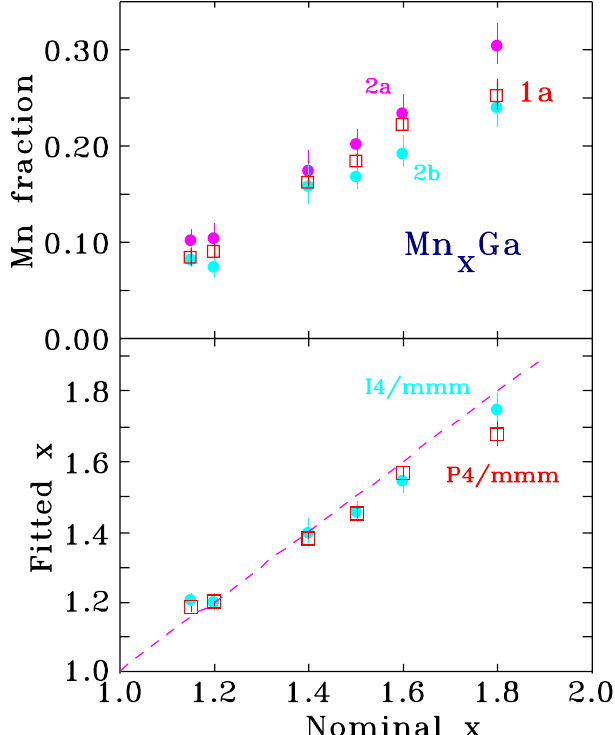
Figure 3. (top) Fitted Mn occupations of the 2 a and 2 b sites (assuming an I4/ mmm cell) compared with the Mn occupation of the 1 a site assuming the simpler P4/ mmm cell). (bottom) Stoichiometry derived from the two models. The dashed line has a slope of one and indicates the expected correspondance between the nominal and fitted